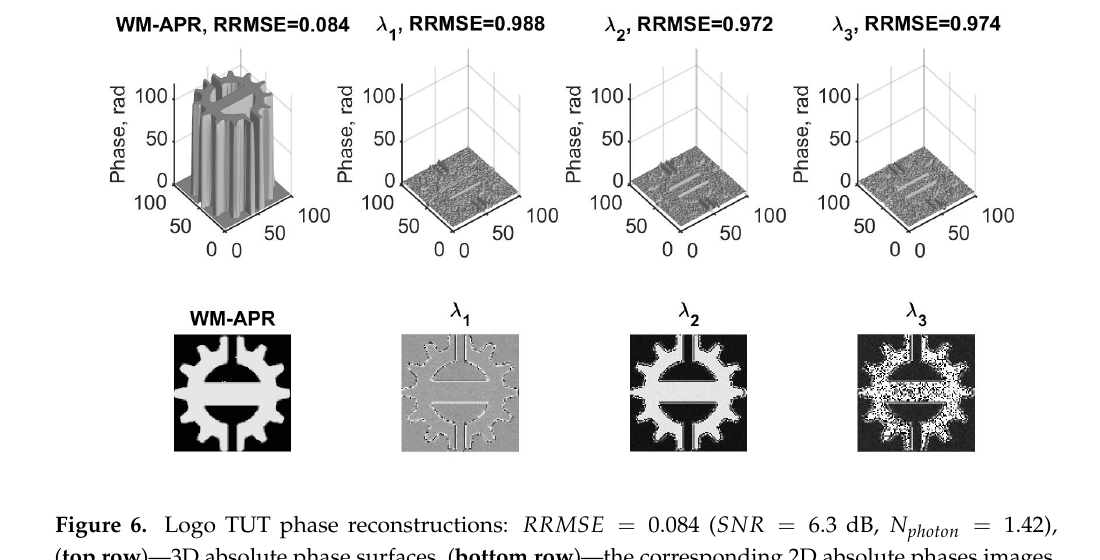
Figure 6. Logo TUT phase reconstructions: RRMSE = 0.084 ( SNR = 6.3 dB, N photon = 1.42), ( top row )—3D absolute phase surfaces, ( bottom row )—the corresponding 2D absolute phases images. From left to right: WM-APR algorithm, and phase reconstructions obtained separately for λ 1 , λ 2 , λ 3 wavelengths, respectively, followed by the 2D phase